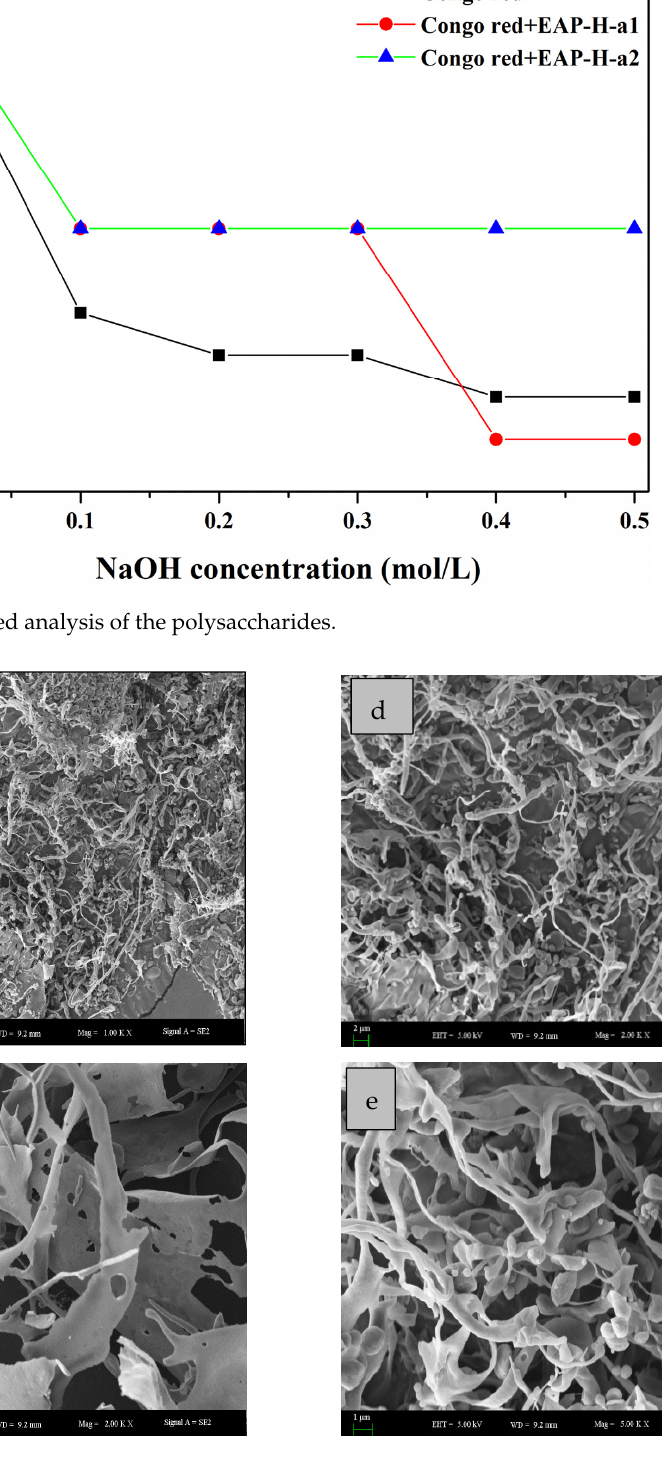
Figure 4. Congo red analysis of the polysaccharides.